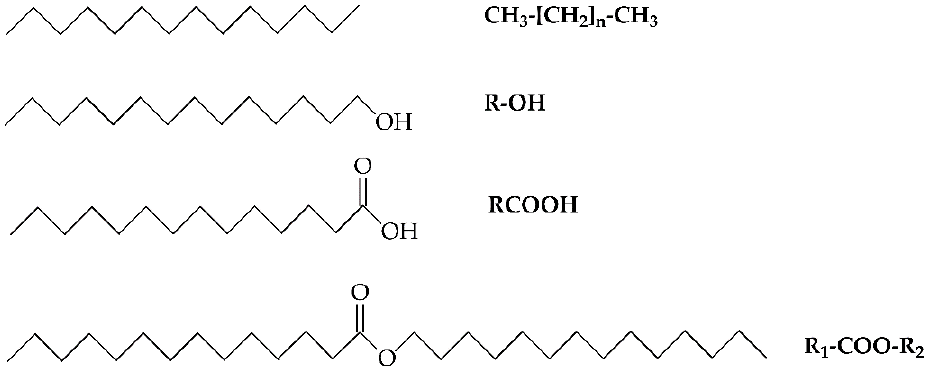
Figure 6. Main types of compounds included in waxes: hydrocarbons ( n -alkanes where n = 22–36), fatty alcohols ( R length is 12–34 carbon atoms), fatty acids ( R length is 12–34 carbon), long-chain esters ( R 1 and R 2 = 10–20 carbon atoms in length).